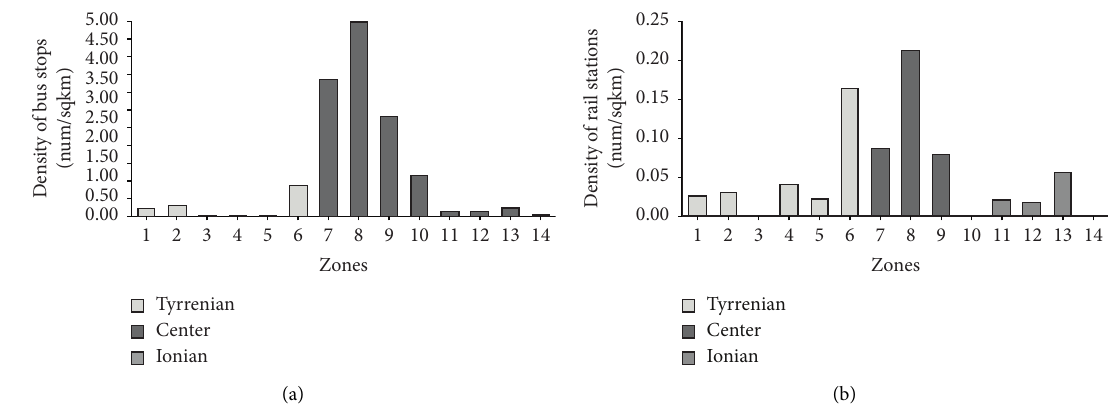
Figure 8: Density of (a) bus stops and (b) railway